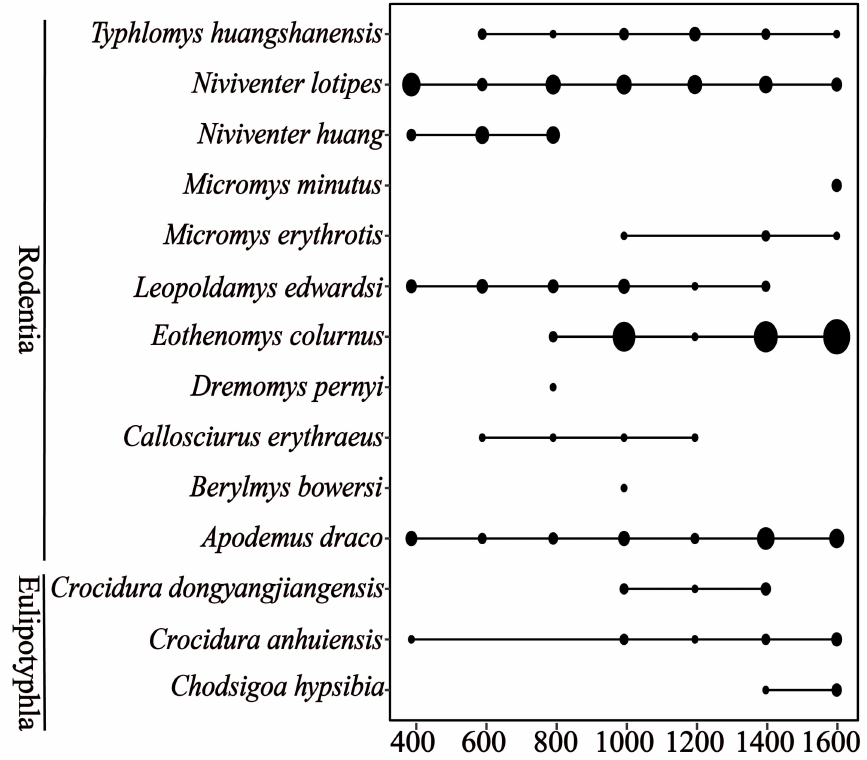
Figure 2. The elevational distribution ranges of small mammal species in Qingliang Mountain used in this